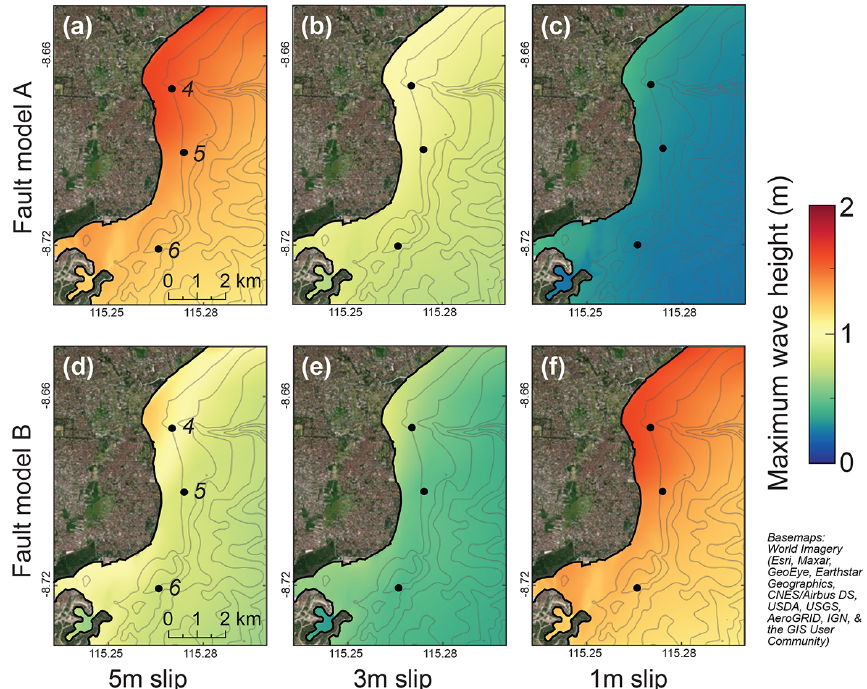
Figure 10. Maximum wave heights in Denpasar generated by slip on fault models A (a–c) and B (d–f) . The highest tsunami wave heights are located within the semi-enclosed bay on the northeast coast. The maximum wave height near Denpasar range is ∼ 1.4m for model A-5 (a) , ∼ 0.9m for A-3 (b) , and ∼ 0.3m for A-1 (c) . The maximum wave heights are slightly lower in fault model B. They are ∼ 0.8m for model B-5 (d) , ∼ 0.6m for B-3 (e) , and ≤ 0.2m for B-1 (f) . Basemaps – World Imagery. Dots – tide